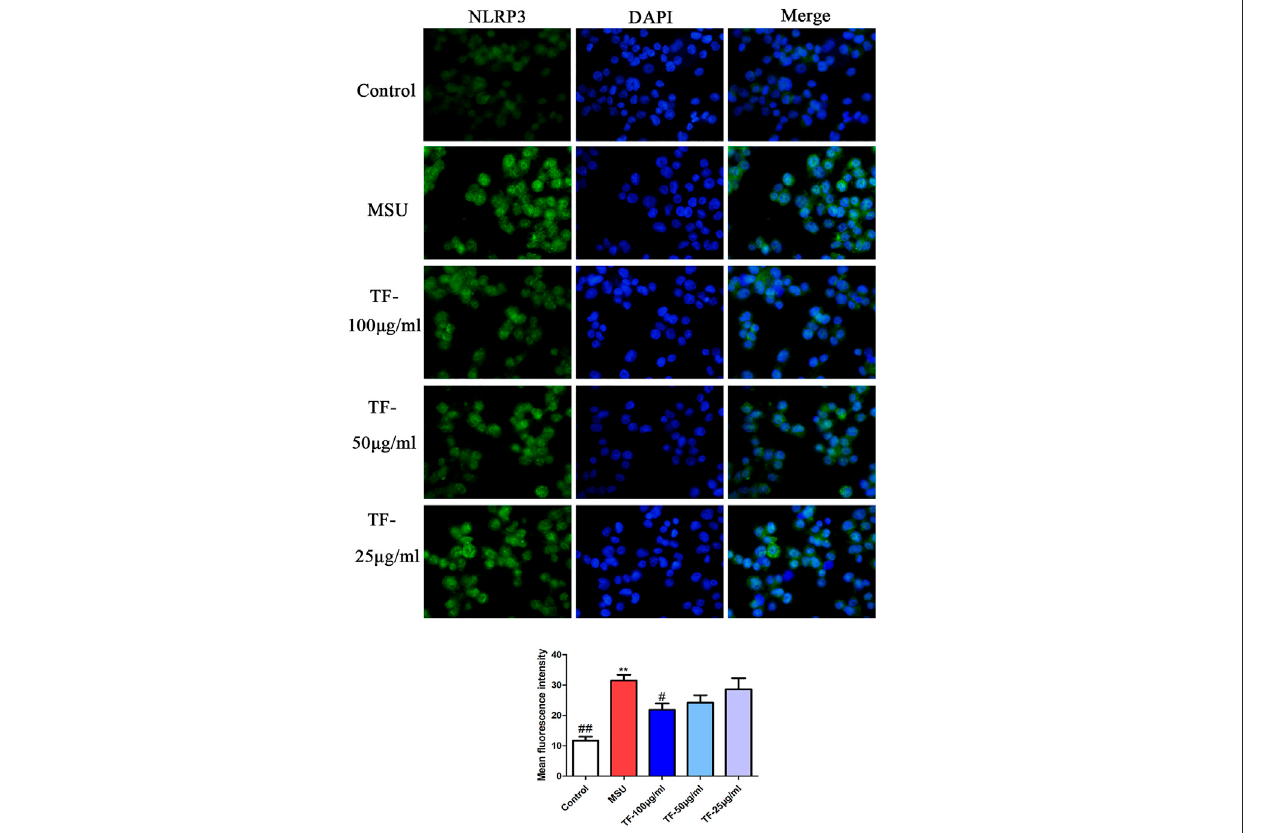
FIGURE 9 | Representative immuno fl uorescence images of NLRP3 protein. NLRP3 (green) and DNA (blue). * p < 0.05 and ** p < 0.01, signi fi cantly different the normal control group; # p < 0.05 and ## p < 0.01, signi fi cantly different the LPS/MSU control group. TF, fl avonoid extract.